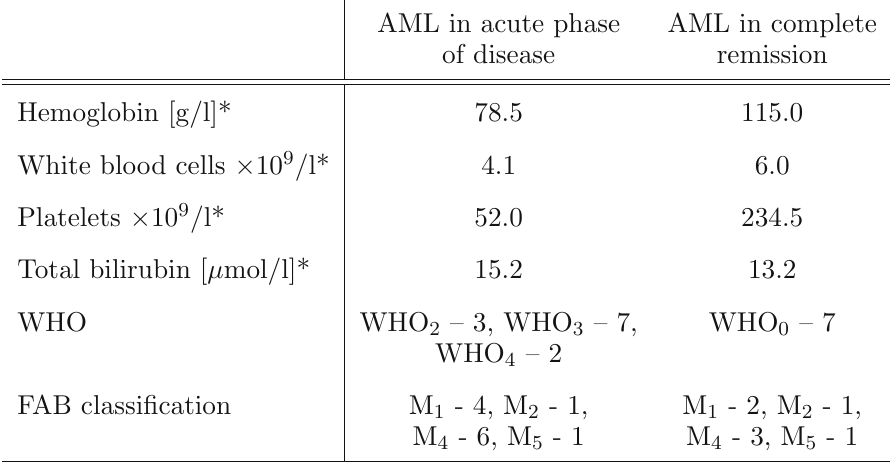
Table 1 Laboratory indices and morphological variant of